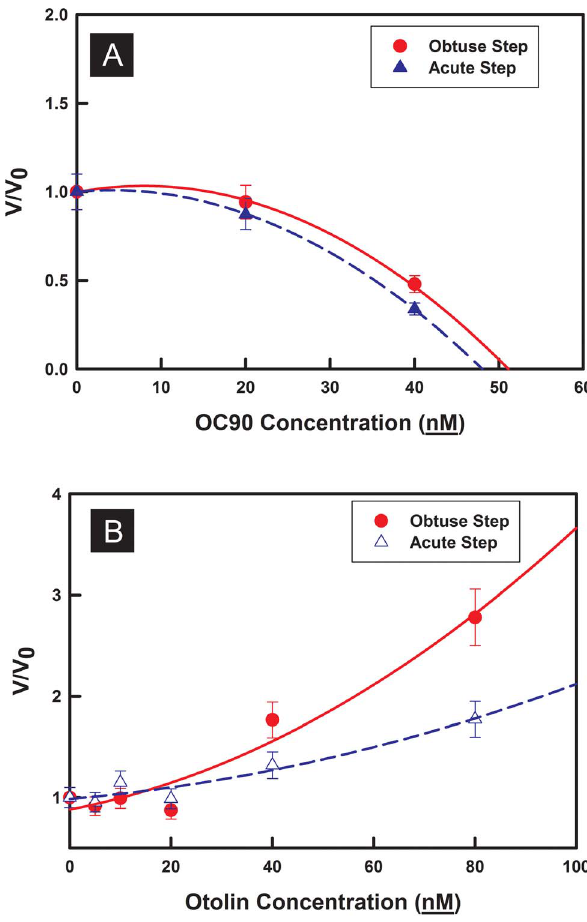
Figure 6. AFM measurements of step propagation rate along both obtuse and acute directions versus rmOC90 or rhOtolin-1 concentration. Normalized step speed rates are shown to exclude the system error between different samples and spirals. (A) Strong inhibition was observed with increasing concentrations of rmOC90. At the concentration of 40 nM the propagation speed was reduced to 30% of the original value. (B) Strong potentiation was observed with increasing concentrations of rhOtolin-1. At 40 nM and 80 nM rhOtolin-1 the propagation speed was increased 177% and 278% of the original value respectively. Error bars (10%) are estimated based on our previous experience with atomic force microscopy measurements [35,36].